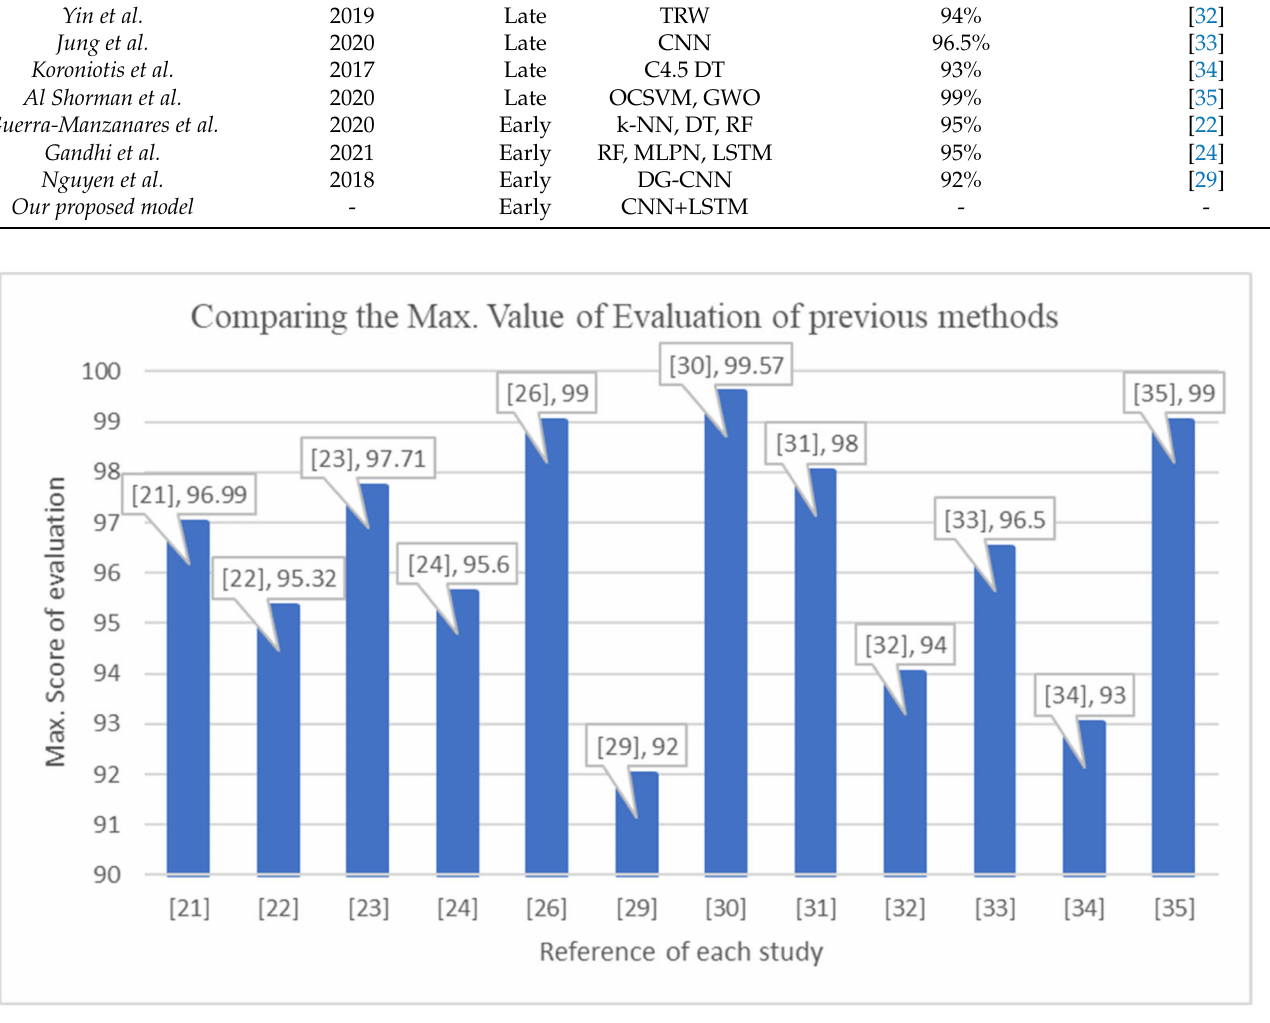
Figure 2. The max. value of evaluation of each method that has been used in state-of-the-art studies to detect IoT botnet in early stage and late